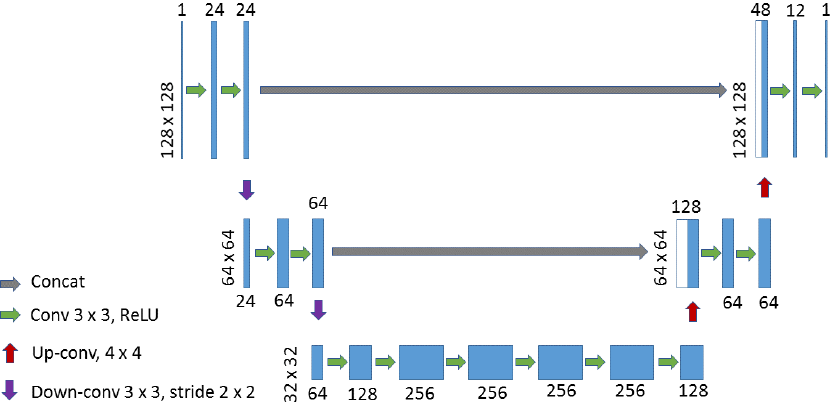
Figure 1. Model architecture for building generalization